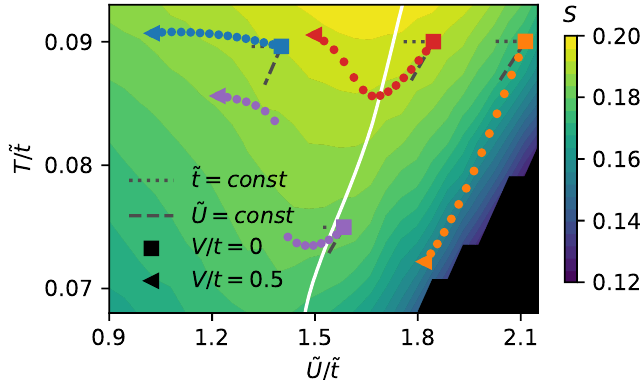
Figure 5: (Color online) Color coded entropy S of the Hubbard model in the region marked by a circle in Fig. 1a). Colored markers represent the effective parameters in this phase space for different nonlocal interactions V (squares: V = 0, triangles: V = 0.5 and dots in between represent linearly increasing values from V = 0 to V = 0.5) and U / t ratios (blue: U = 1.6, red: U = 2.1, yellow: U = 2.4 and t = 1.14, respectively. Purple: U = 2.1 and t = 1.26) at T = 0.1. The lines show the directions of constant ˜ U (dashed) and ˜ t (dotted). The white line shows where the variation of ˜ t and that of ˜ U leads to the same free energy gain for infinitesimal V (see